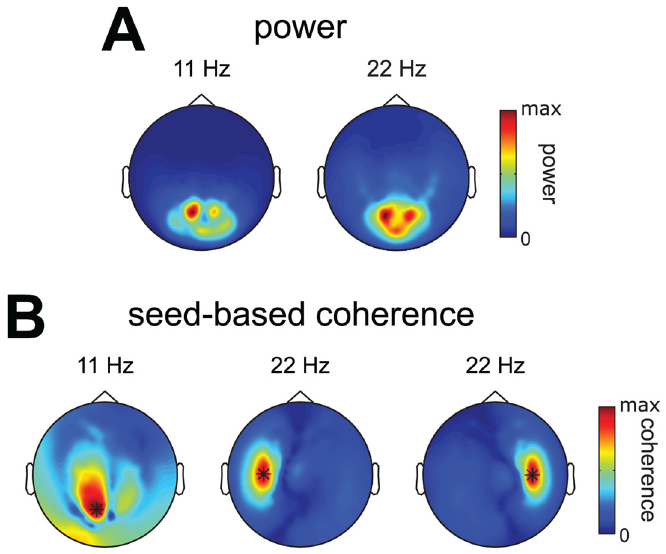
Fig 5. Alpha and beta power and seed-based coherence of the representative subject. To compare the extracted components of our representative subject (Fig 4) to conventional pairwise analyses we computed power and coherence using the same CSDs as were used to extract components. A , spatial topography of alpha and beta power. B , spatial topography of alpha coherence seed from a posterior sensor, and spatial topography of beta coherence seeded from two sensorimotor sensors. Observe that (1) the analysis of power suggests only occipital activity, (2) occipital seed-based alpha coherence shows distributed coupling over many occipital sensors, and (3) sensorimotor seed-based beta coherence reveals sensorimotor sources with a monopolar pattern. When comparing this to the components extracted using the same CSDs (Fig 4) we observe (1) that occipital alpha power and coherence originated from many overlapping and separable alpha sources, and (2) that there are clear dipolar beta patterns over sensorimotor cortex, strongly suggesting point sources. That these observations cannot be made in power and seed-based coherence illustrates an important point: due to summation of multiple sources sensor-level power and coherence is a very indirect way of studying neuronal activity. Extracting components using our method allows for separating overlapping sources and to analyze them